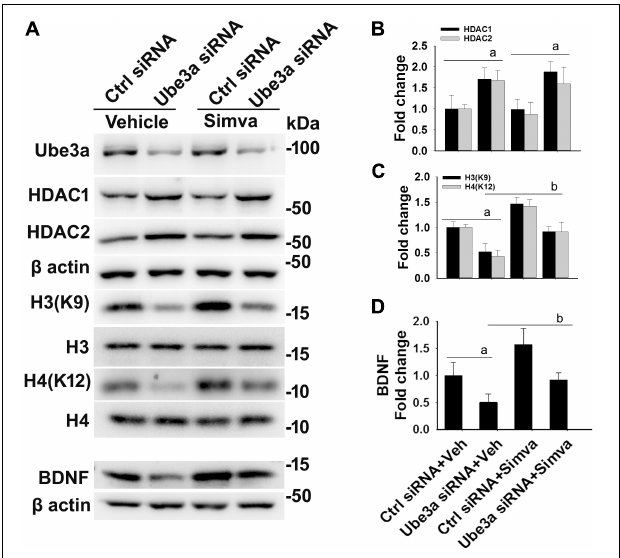
FIGURE 5 | Oral administration of simvastatin significantly recovers the reduced acetylation of histones H3/H4 and altered level of BDNF in AS mice brain. (A) Adult wild type and AS mice were orally administered simvastatin (1 mg/kg body weight) for 60 days, cortices were dissected out, lysed and subjected to immunoblotting using antibodies against Ube3a, HDAC1/2, histones H3/H4 and their acetylated derivatives and BDNF. (B–D) Quantitation of band intensities of HDAC1/2 (B) , acetylated histones H3/H4 (C) , and matured BDNF (D) as described in Figure 1 . Each lane represents sample from the different mouse. Values plotted are mean ± SD with four mice in each treatment group. Data were examined by one-way ANOVA followed by Holm–Sidak post hoc test. The ‘a’ represent P < 0.01 compared to vehicle or simvastatin treated wild type mice group while “b” denote P < 0.01 with respect to vehicle treated AS mice group.